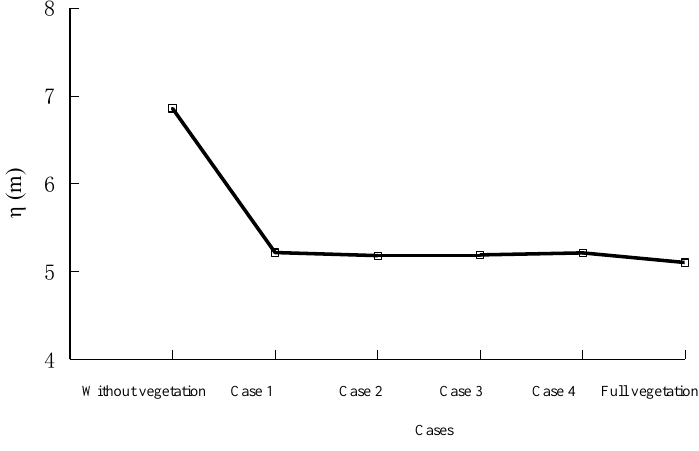
Figure 16. The comparison of maximum run-up heights.